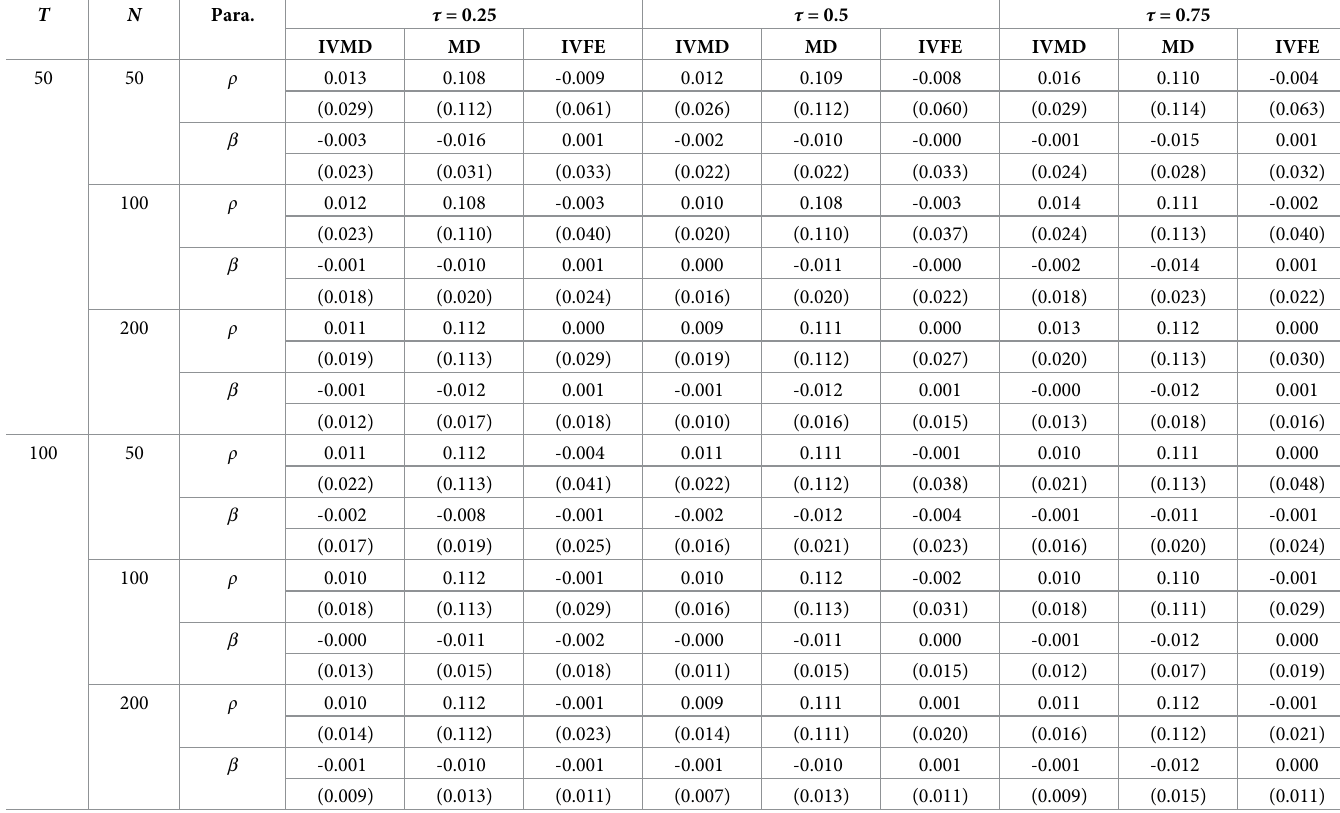
Table 1. Bias and RMSE (in parentheses) of various estimators in the homoscedastic case. T N